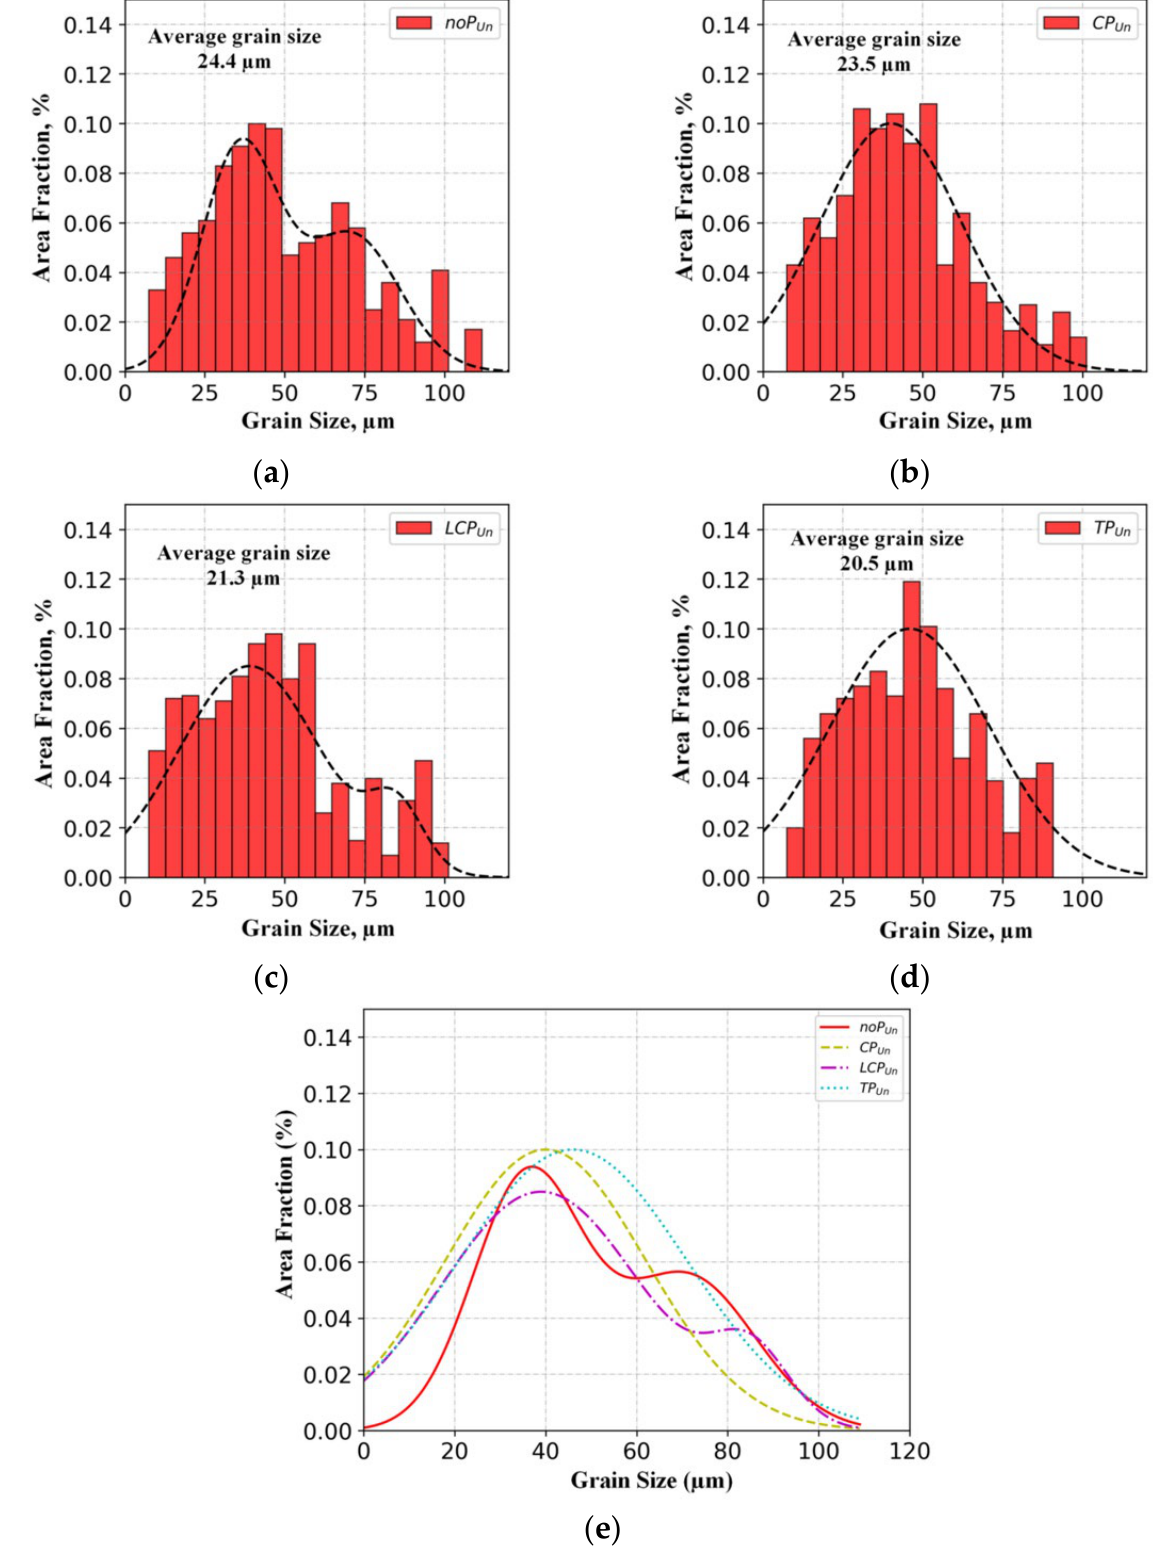
Figure 10. Grain size distributions of ( a ) noP Un , ( b ) CP Un , ( c ) LCP Un , and ( d ) TP Un ; ( e ) Log-normal distribution of grain size for each treatment.